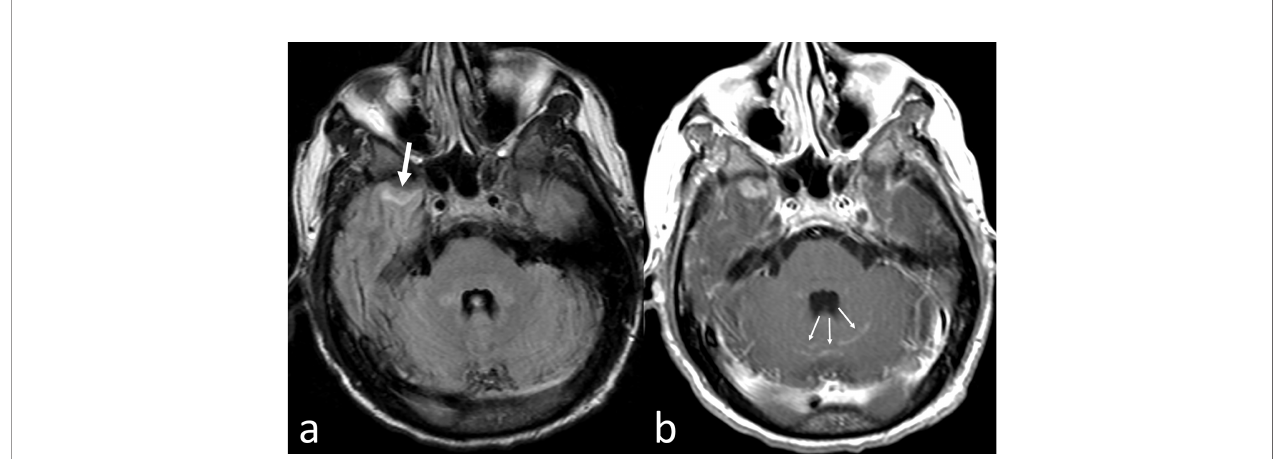
FIGURE 1 | CNS-MM. Despite artifactual images from patient ’ s movement, fast fl uid-attenuated inversion recovery axial MR image (A) shows a small area of abnormal intensity in the surface of the anterior pole of the right temporal lobe (thick arrow). Corresponding Gadolinium-enhanced T1-weighted axial MR image (B) shows enhancement not only of the left temporal lesion but also in some cerebellar sulci (thin